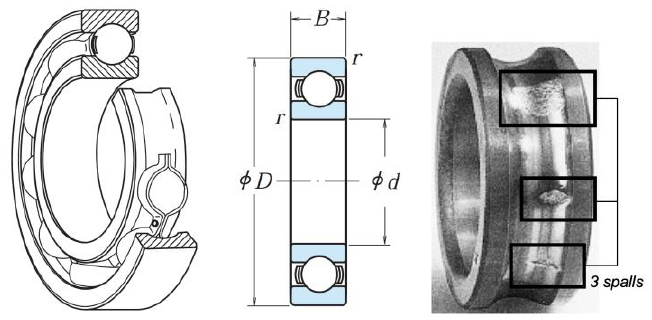
Figure 2. Bearing 6208 ZZ C3. Table 2. Bearing data sheet.